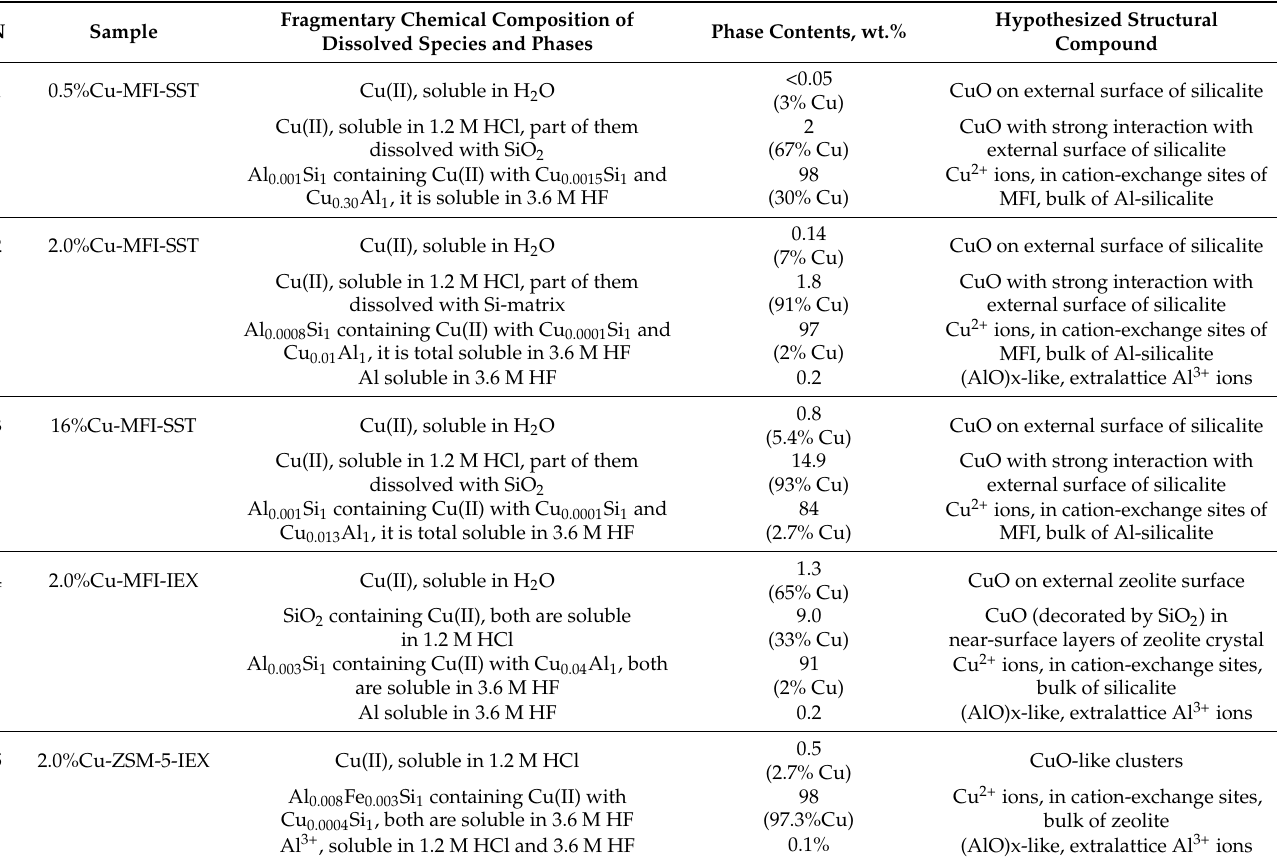
Table 2. Results of the chemical differentiating dissolution of Cu-containing